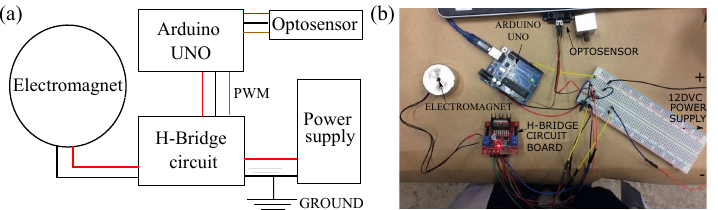
Figure 3. ( a ) Circuit wiring schematic where the red and black wires denote positive and negative po- larity, respectively, and the brown wires denotes a signal; ( b ) image of circuit showing electromagnet, h-bridge circuit (L298N), arduino UNO, optosensor, and power supply. The circuit controlled the frequency of actuation of the electromagnet and therefore the membrane